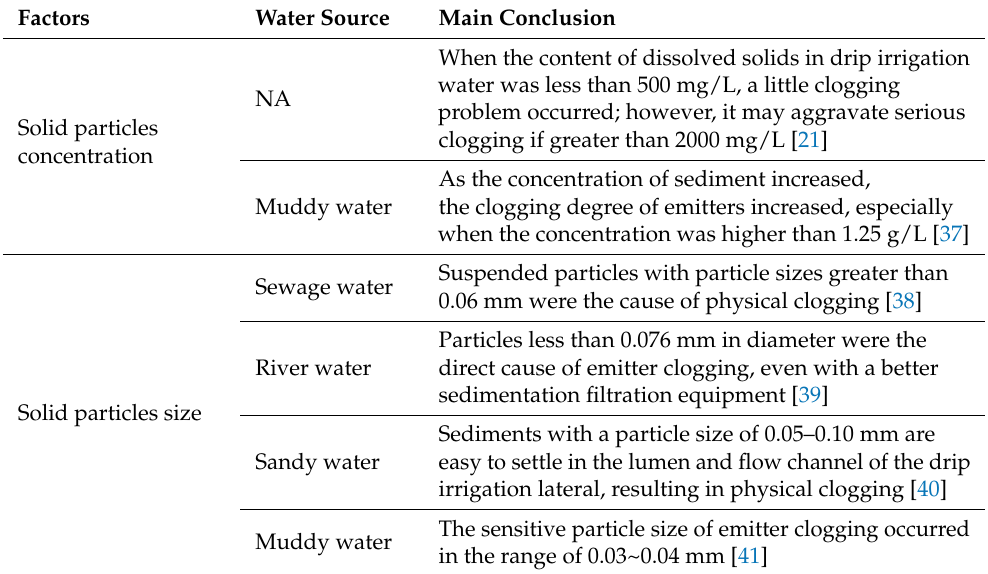
Table 1. Emitter clogging caused by solid particles under different water sources.